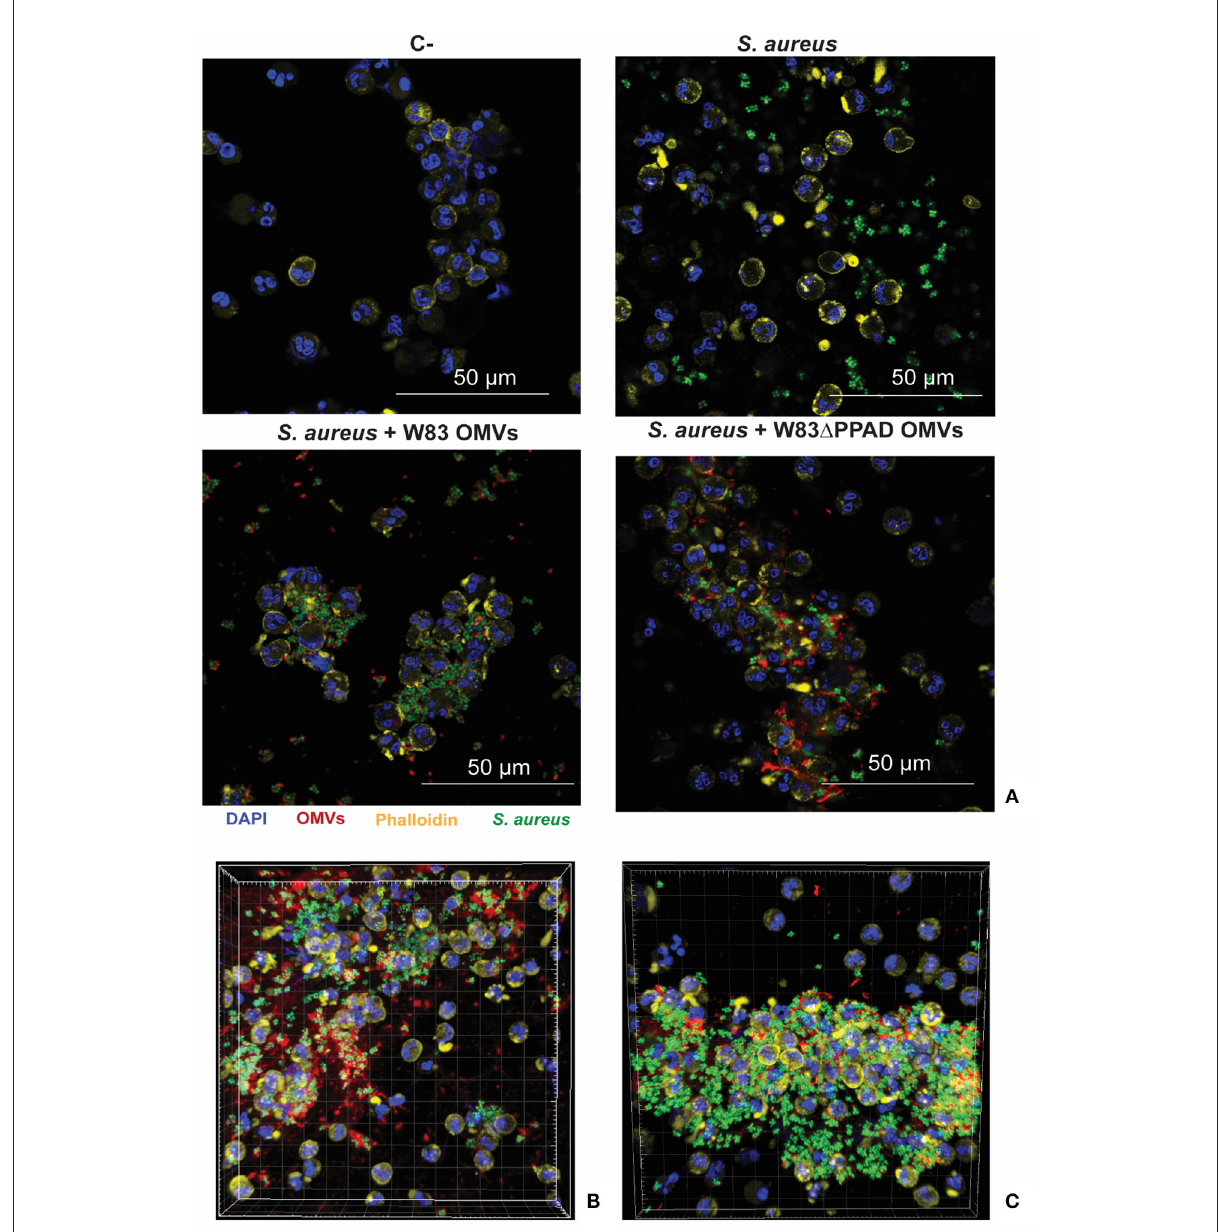
FIGURE5 Neutrophil association and internalization of S. aureus upon exposure to P. gingivalis OMVs. (A) Representative confocal microscopy images of neutrophils infected with S. aureus HG001 that was exposed to P. gingivalis OMVs. (B,C) Three-dimensional reconstructions of confocal fluorescence microscopy images of neutrophils incubated with S. aureus in the presence of OMVs from P. gingivalis W83 (B) or OMVs from P. gingivalis W83 1 PPAD. (C) DAPI was used to stain the nuclei of the neutrophils and Phalloidin-TRITC to stain actin. S. aureus was detected based on GFP expression from plasmid pJL-sar-GFP and OMVs were labeled with specific antibodies (scale bars = 50 µ m). Each experiment was repeated at least